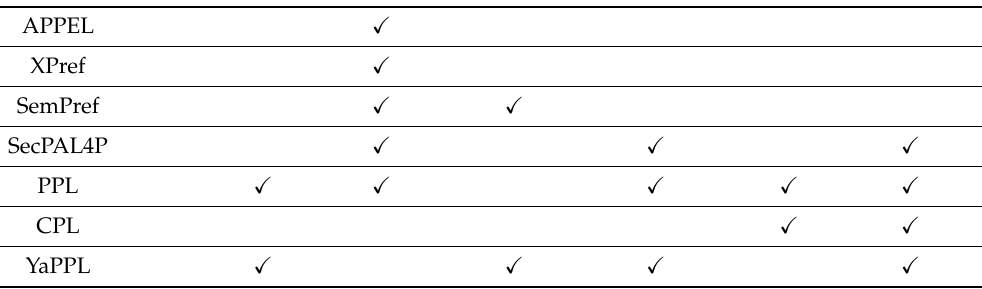
Table 1. Overview of requirements for a novel preference language and which languages meet them. The requirements without any particular ordering are privacy language compatibility (pl comp) , GDPR compliance , transparency , human-readability (readable), expressiveness , context information and extensibility